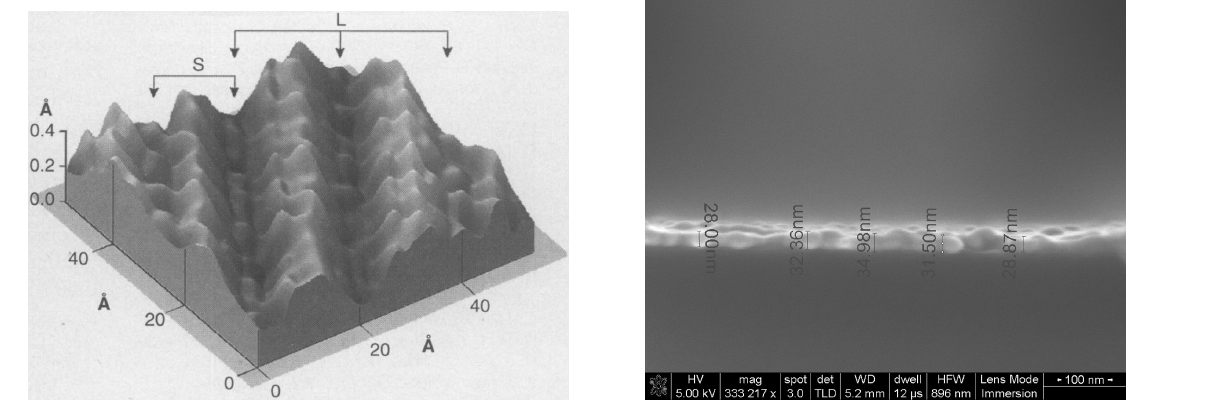
Figure 4: A 3D rendering of an STM image showing atomically smooth silver layers. Reproduced with permission from [65].